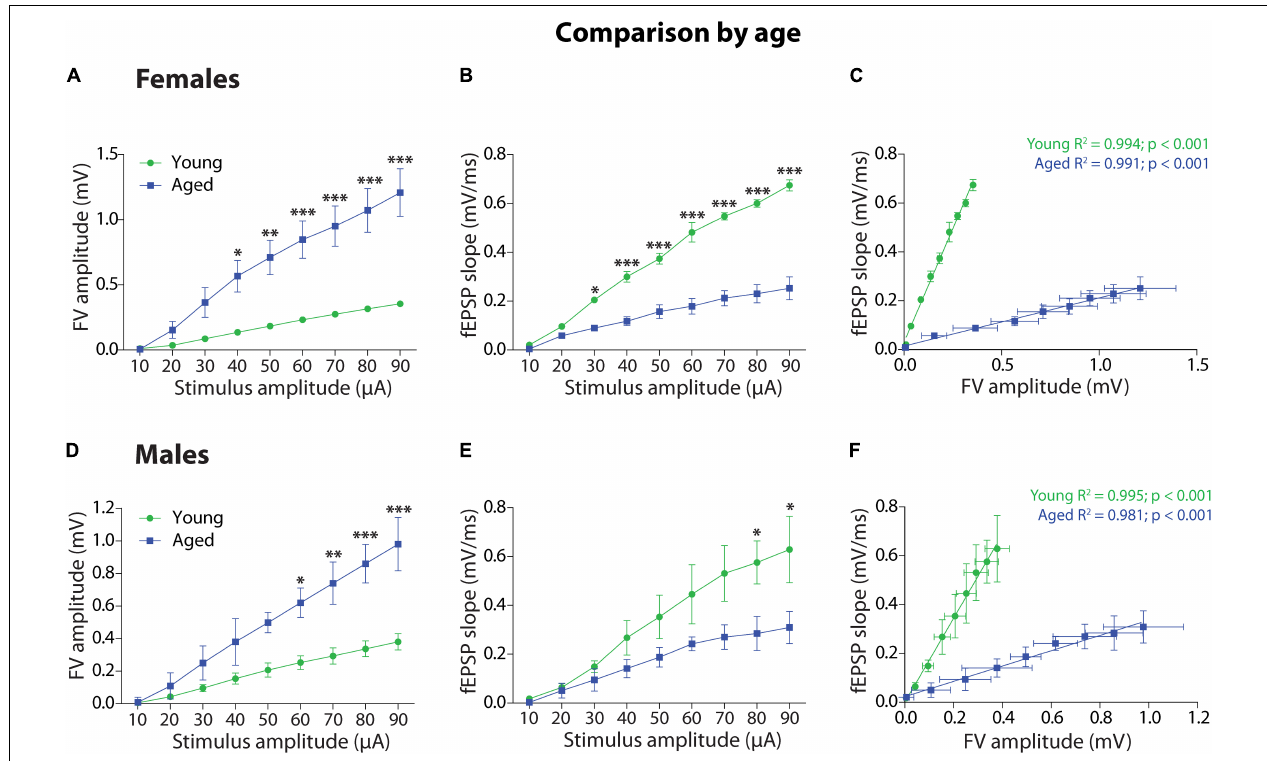
FIGURE 2 | Age comparison of the synaptic transmission basal parameters at Schaffer collateral-CA1 synapse of young and aged female and male degus. (A,B) Input–output relationship between different stimulus intensity (10–90 µ A) and the fiber volley amplitude (A) or the fEPSP slope (B) in young and aged female ( A,B , 12–24 months old; n =